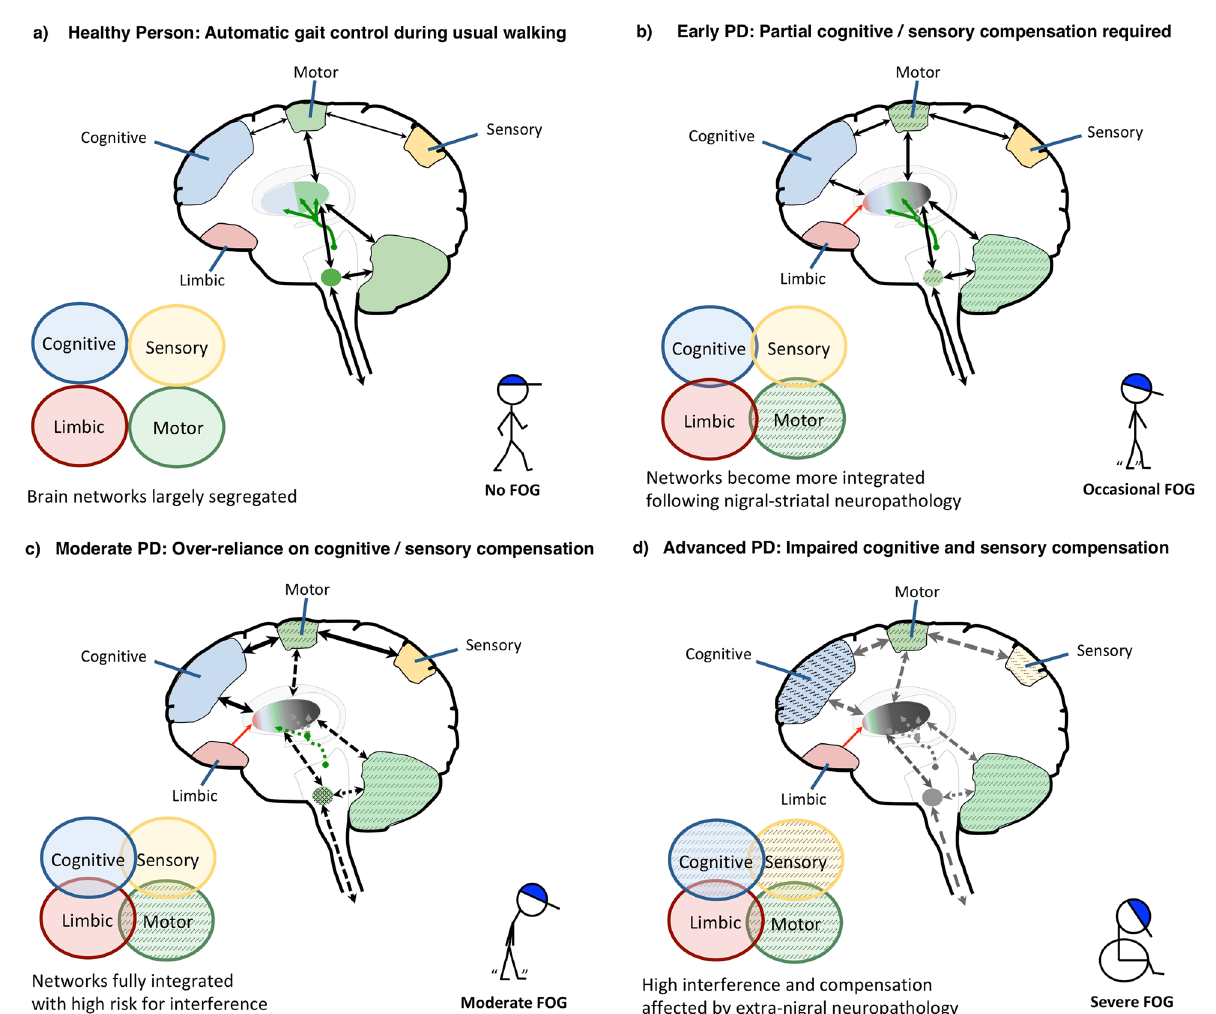
Fig. 1 Theoretical model of gait control in healthy persons and PD patients with FOG. a In healthy individuals, gait automaticity is achieved via processing across dorsal cortico-striatal-thalamo-cerebellar-brainstem neural circuits. Segregation of the motor circuit from other, i.e., sensory, limbic, and cognitive circuits, allows consecutive processing of multiple inputs without interference, ensuring normal gait automaticity. Note, however, that gait is not always automatically controlled. Attentional control will be called upon in gait during complex circumstances. The need for attentional gait control increases with older age and more so in pwPD. b Following substantial degeneration of nigral-striatal dopaminergic neurons (indicated by gray coloring in the dorsal striatum) already prominent in early PD, gait automaticity becomes impaired. External sensory input and cognitive control come on to maintain gait control (as indicated by the increase in black arrows, modeling greater inter-circuit connectivity). Occasional FOG occurs when processing demands exceed the combined capacity of motor and compensatory circuits. Limbic input to the striatum (indicated by red arrow) may increase interference and exacerbate FOG. c The progression of nigral-striatal neurodegeneration inherent to moderate PD heavily affects processing across the motor circuit (indicated by dotted arrows), increasing the dependency on compensatory circuits. The risk for interference during gait becomes higher, resulting in regular episodes of FOG. d In the advanced stages, extra-nigral neuropathology starts to affect processing across the compensatory circuits (indicated by the gray dotted arrows), resulting in severe gait disability and frequent